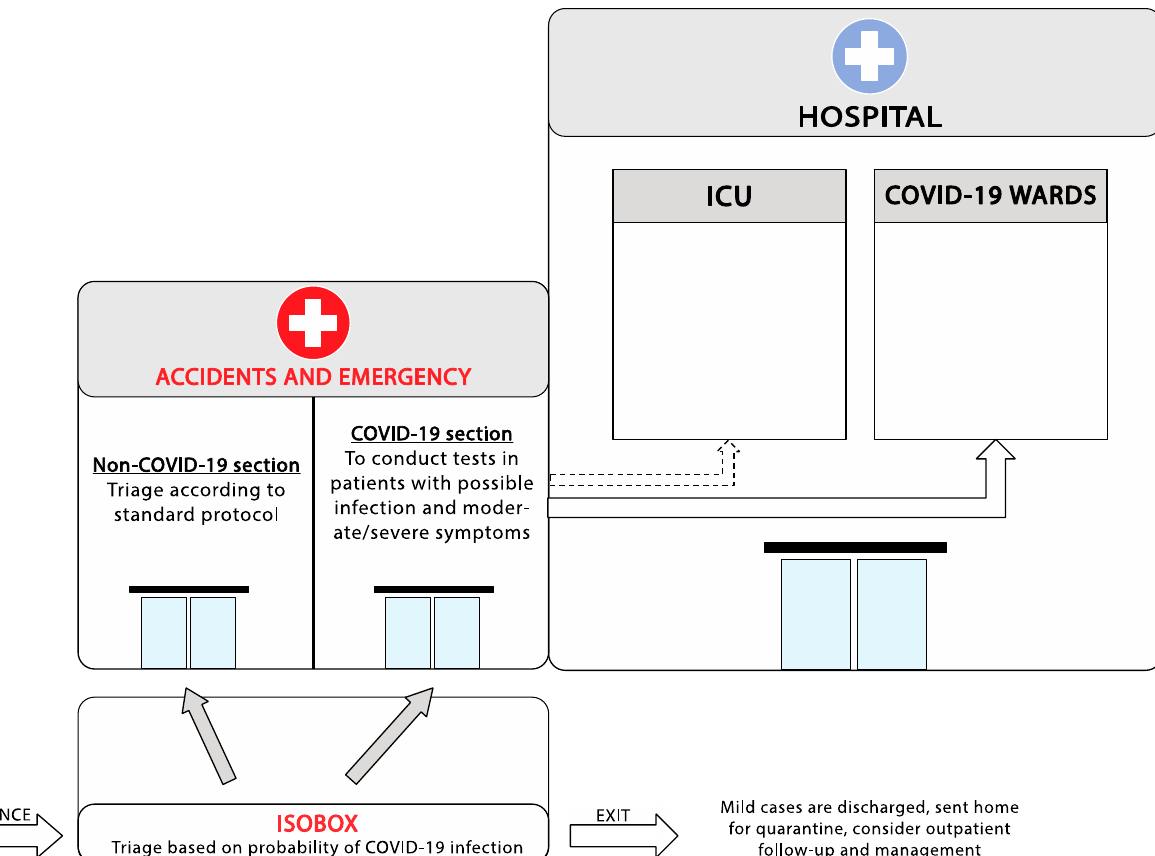
Figure 1. Emergency department reorganization for the management of COVID-19 outbreak.